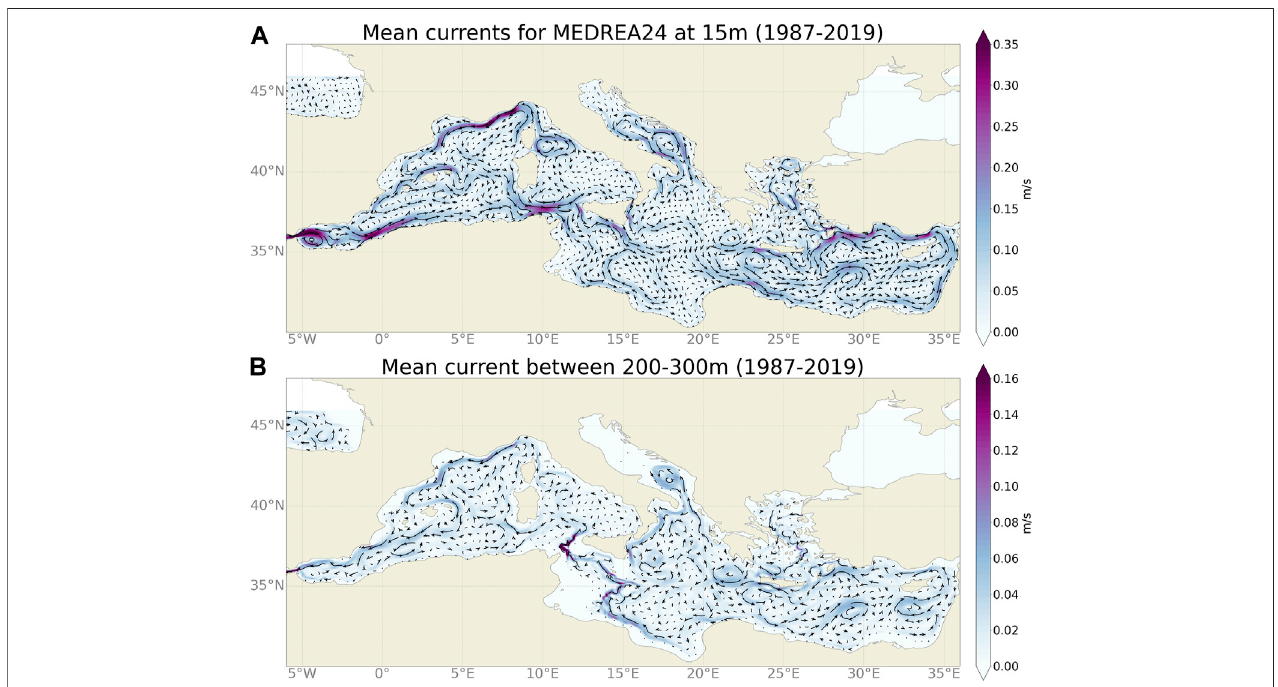
FIGURE 11 | Average currents from MEDREA24 at 15 m (A) and between 200 – 300 m depth (B) for the period 1987 – 2019.